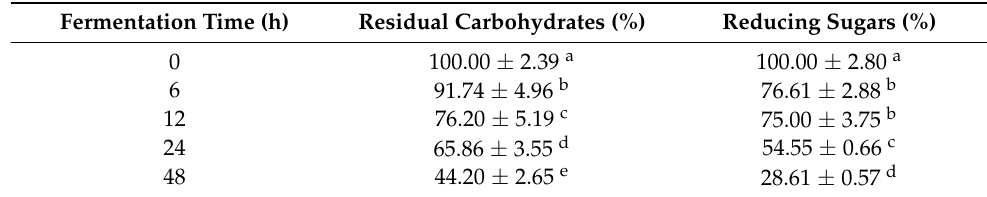
Figure 2. HPLC profiles of CPP during fermentation ( A , B ), and pH changes of the fermentation cultures. The retention times of the pullulan standards p1–5 ( A , B ) were 18.3, 17.2, 16.0, 14.8, and 13.0 min, respectively. Different letters in the same group ( C ) represent significant differences ( p < 0.05) at different time points. Table 1. Content changes of residual carbohydrates and reducing sugars of CPP during fecal